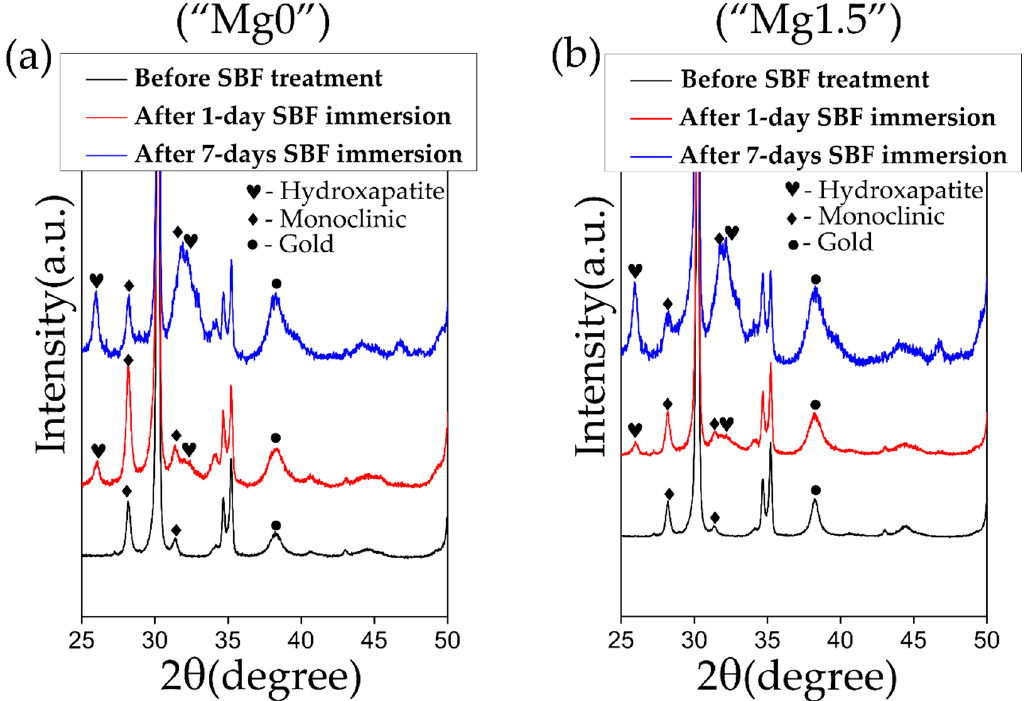
Figure 7. XRD plots comparing properties of ( a ) “Mg0” solution and ( b ) “Mg1.5” solution-treated 3Y-TZP samples before and after 1 day or 7 days SBF immersion.